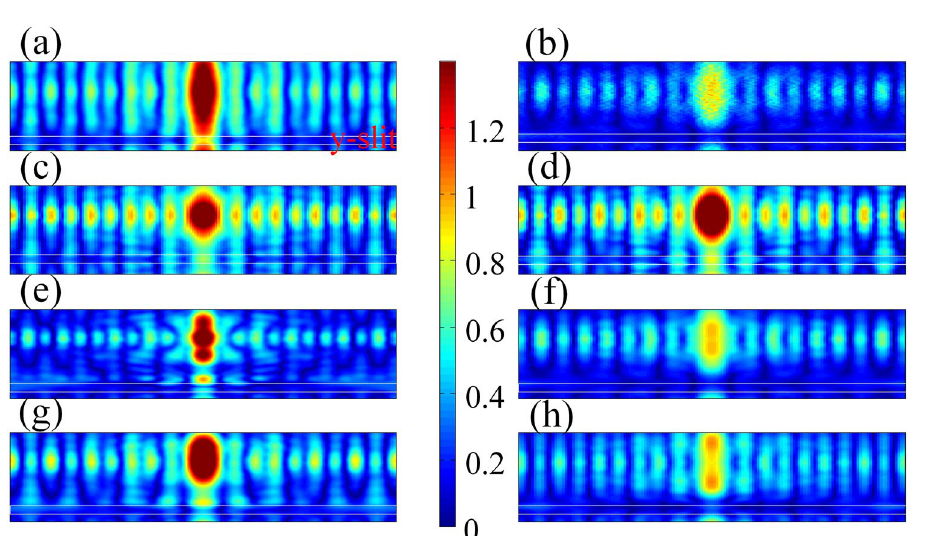
Figure 4. The distribution of the SW-SPs in the water film of MSS under different parameters errors: ( a ) no fabrication error, ( b ) the surface roughness of up Ag and Al 2 O 3 films, the width of slits: ( c ) 45 nm (with 5 nm width error) and ( d ) 55 nm (with 5 nm width error), the thickness of up Ag layer: ( e ) 8 nm (with 2 nm thickness error) and ( f ) 12 nm (with 2 nm thickness error), and the thickness of bottom Ag layer: ( e ) 98 nm (with 2 nm thickness error) and ( f ) 102 nm (with 2 nm thickness